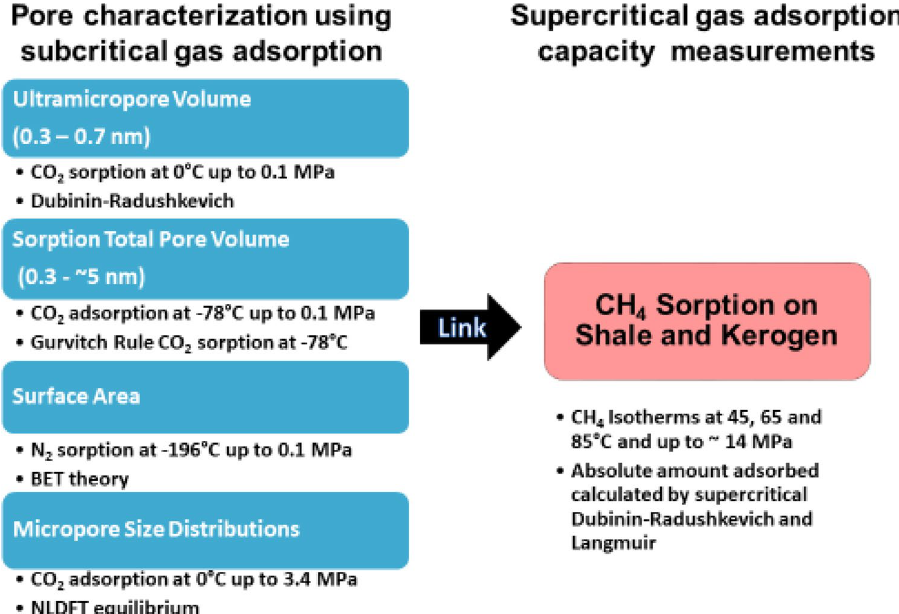
Fig. 7 Pore characterization using adsorption based meth-